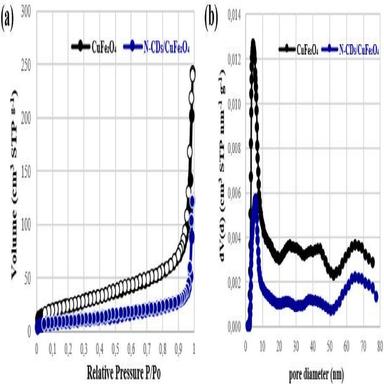
(a) N2 adsorption/desorption isotherms and (b) Pore size distribution of CuFe2O4 and N-CDs/CuFe2O4. (A colour version of this figure can be viewed online.)